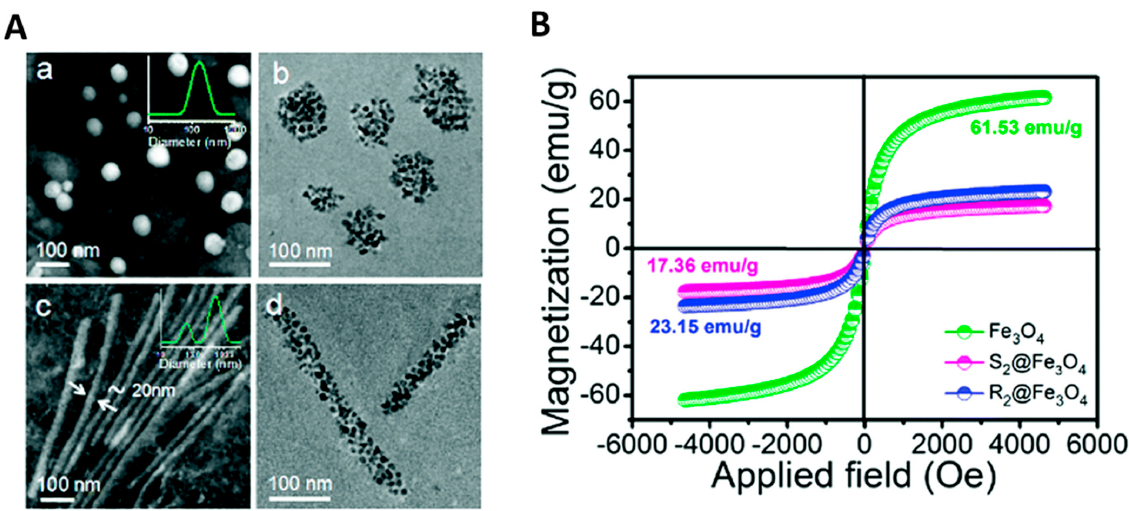
Figure 2. The influence of the shape in the magnetization of magnetic polymeric micelles. ( A ) TEM images of micelles produced with PBA-PEG-PCL@Fe 3 O 4 with spherical ( a , b ) or rod-like ( c , d ) morphology. Images in ( a , c ) represent micelles without Fe 3 O 4 while ( b , d ) refer to magnetic polymeric micelles. In panels ( a , c ), the inserted images indicate the nanoparticle size distribution. ( B ) The magnetization loop was performed on the magnetic particles (Fe 3 O 4 ) and the spherical (S 2 @Fe 3 O 4 ,) and rod-like (R 2 @Fe 3 O 4 ) micelles at room temperature by vibrating sample magnetometry. Adapted with permission from Ref. [85]. Copyright 2022, The Royal Society of Chemistry .